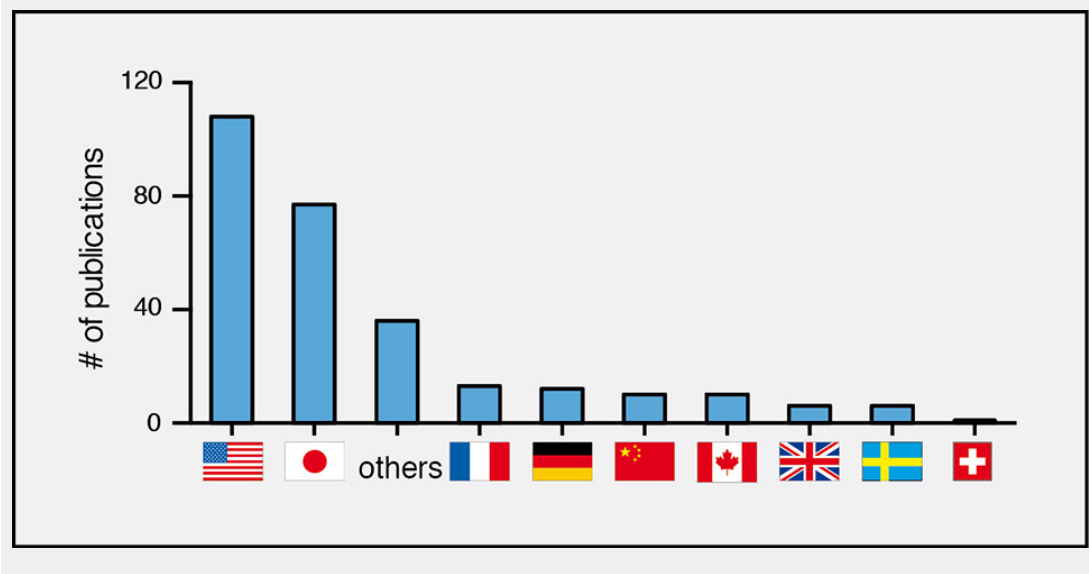
Figure 4 Parabiosis in different countries. Publications including parabiosis experiments are listed for different countries. All values have been extracted from